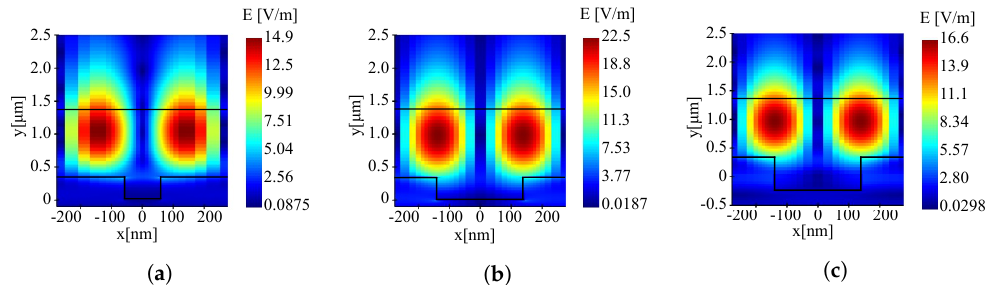
Figure 7. The electric field distributions for GMR gratings in EpoCore with different fill factors and grating heights: ( a ) FF=0.2, d gr = 350 nm, ( b ) FF=0.5, d gr = 350 nm and ( c ) FF=0.2, d gr = 600 nm.